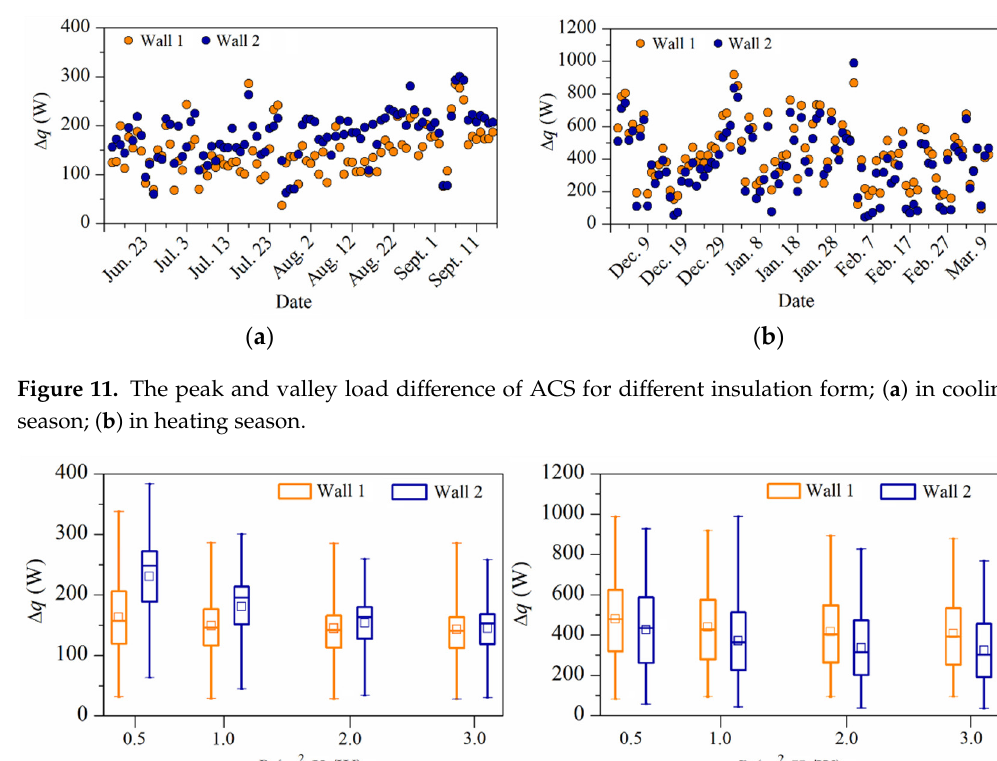
Figure 11. The peak and valley load difference of ACS for different insulation form; ( a ) in cooling season; ( b ) in heating season.